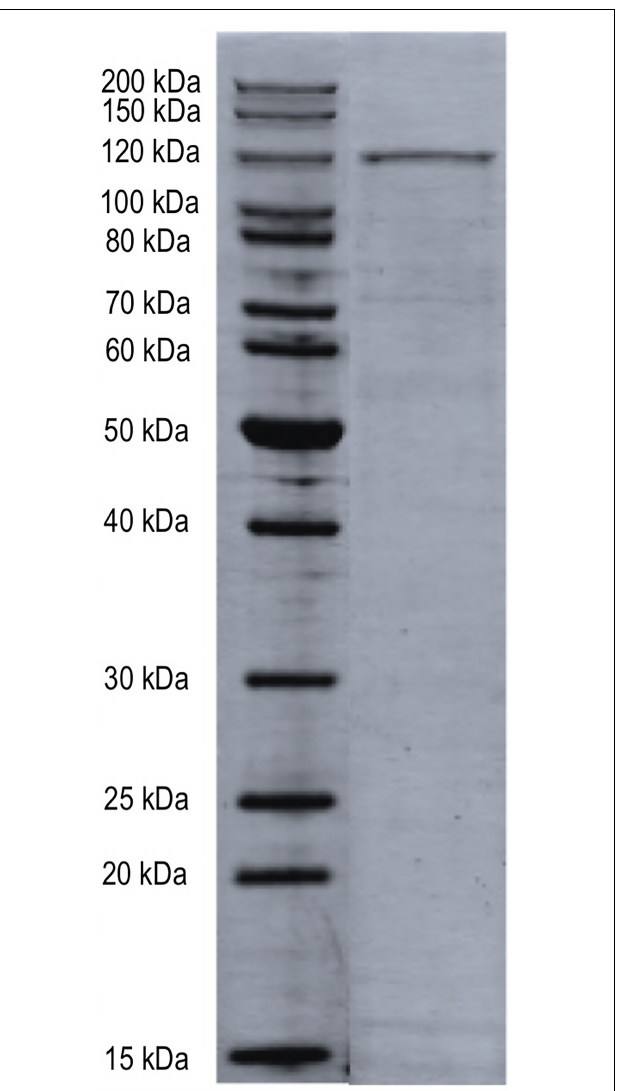
FIGURE 1 | SDS–PAGE of NAC-purified MopA-hp. NAC-purified bulk sample was analyzed by trypsin digestion and LC–MS/MS. The proteins identified in this sample are indicated in Table 3 . Molecular weight size standards as indicated.